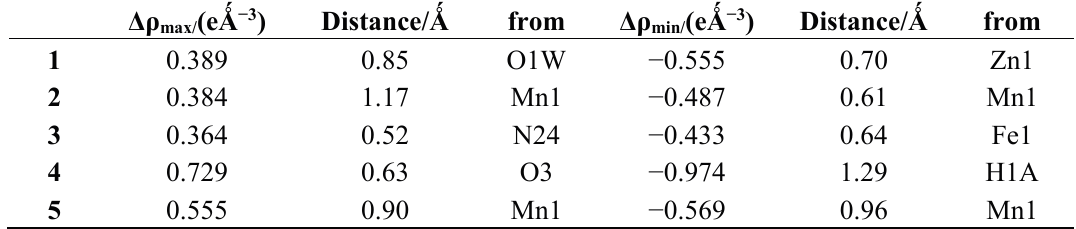
Table 7. Highest peaks and deepest holes for structure refinement data for compounds 1 – 5